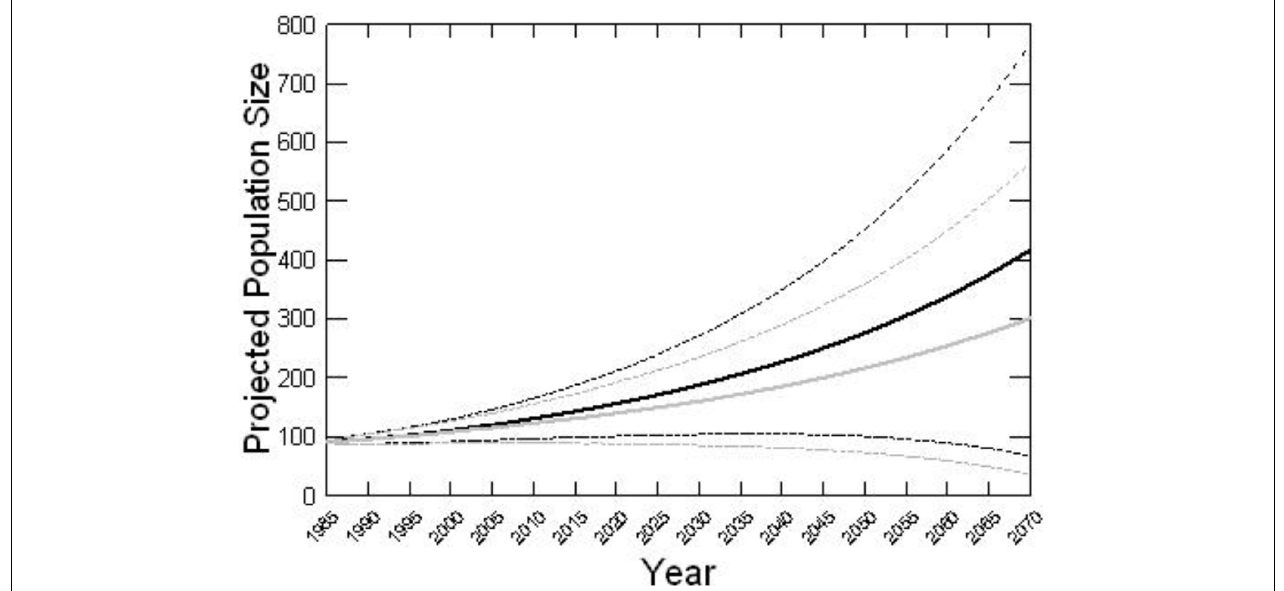
FIGURE 4 | Population projections. Mean population trajectory for Sarasota Bay from the Vortex population model with interventions (black line) versus without interventions (gray line). Dotted lines show the mean trajectories +1 SD and –1 SD. TABLE 3 | Population